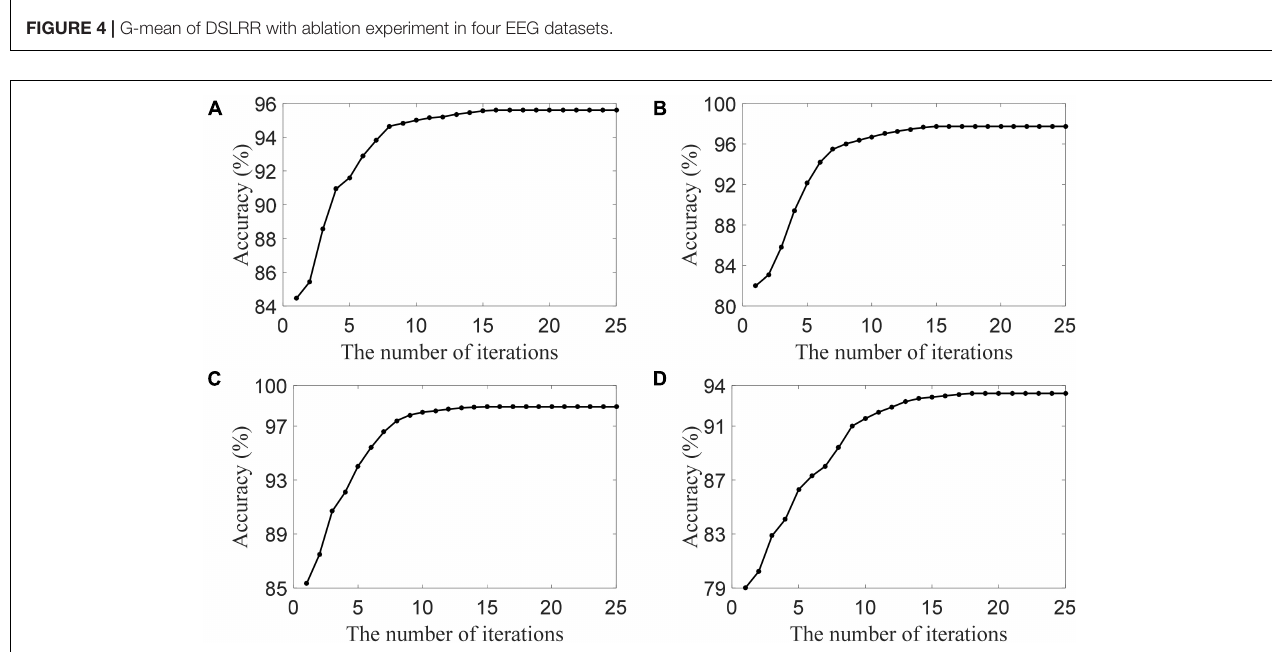
FIGURE 5 | The convergence of the DSLRR algorithm in four datasets, (A) HC and AD, (B) HC and MCI, (C) HC and (MCI+AD), and (D) MCI and